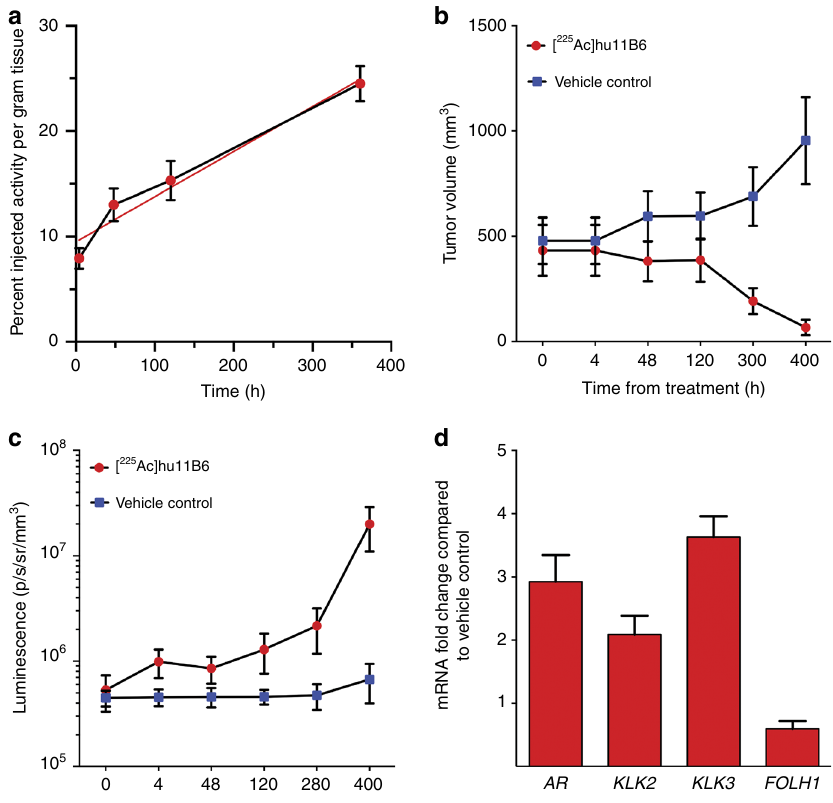
Fig. 4 Alpha particles promote a feed-forward oncoaddictive effect that promulgates lethality. a The increasing uptake of [ 225 Ac]hu11B6 is shown as %IA/g (red- fi lled circles with a blue connecting line) in LNCaP-AR tumor at four time-points after IV administration. This escalating rate of drug accumulation in tumor is noted by the linear regression fi t (solid red line) with slope = 0.037 ± 0.001 %IA/g/h. b Therapeutic ef fi cacy of a single administration of [ 225 Ac] hu11B6 is evidenced by the decreasing tumor volumes compared with vehicle-treated controls where the trajectory of untreated tumor volumes steadily increase with time. c These data report the measured AR-driven luciferase bioluminescence signal (photons/s/mm 2 /sr) vs. time in the treated and control animals. Note that while the alpha irradiated tumor volume decreases (see panel 4B) with time while AR-driven BLI signal increases. These data show upregulation of AR expression as a consequence of alpha irradiation with [ 225 Ac]hu11B6. d RT-PCR analysis of AR and AR -driven genes in tumor tissues collected from [ 225 Ac]hu11B6- and vehicle-treated mice at 400 h. The fold-change in tumor gene activity of treated animals normalized to non-treated tumors shows increased expression of AR , KLK2 , and KLK3 , but not